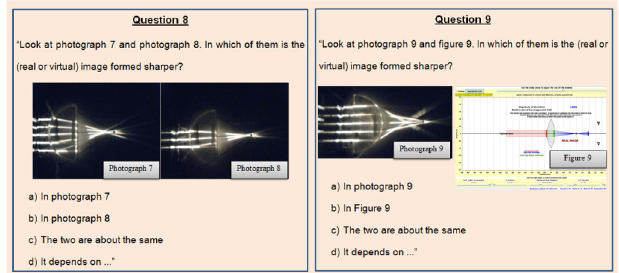
FIG. 5 (color online). Two of the questions of the test. The full test can be seen in Ref.